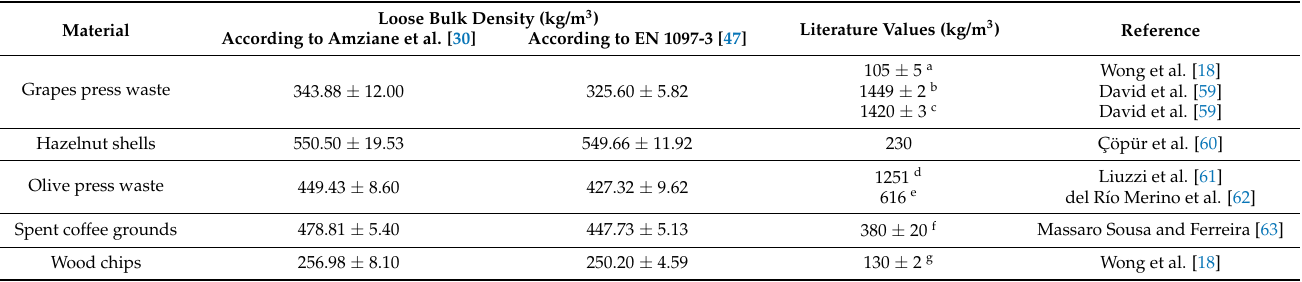
Table 4. Measured loose bulk density of the analysed bio-wastes and comparison with literature values.